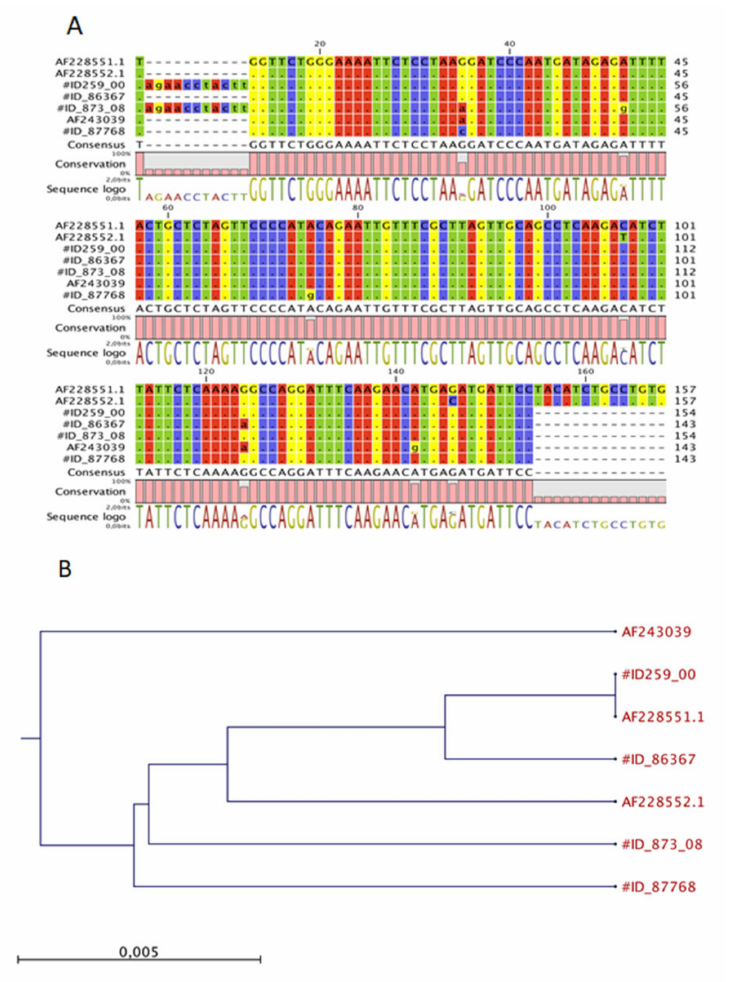
Figure 3. Multiple nucleotide alignment of the MMTV-like env gene sequences and phylogenetic analysis. ( A ) The env sequences from two new FMCs, #ID 28983 and #ID 873/03 respectively were aligned with NIH 3T3 (positive control for MMTV), MMTV from HeJ mice, and HMTV (Accession Numbers AF228551.1 and AF243039, respectively) and previous sequences already deposited by Civita et al. [22]; ( B ) a neighbour-joining phylogenetic tree from nucleotide sequences of env of MMTV viruses. The tree was rooted to MMTV sequences. The robustness of individual nodes of the tree was determined by using bootstrap analyses of 1.000 replicates. Table 2. Pathologic features of the 102 feline mammary carcinomas